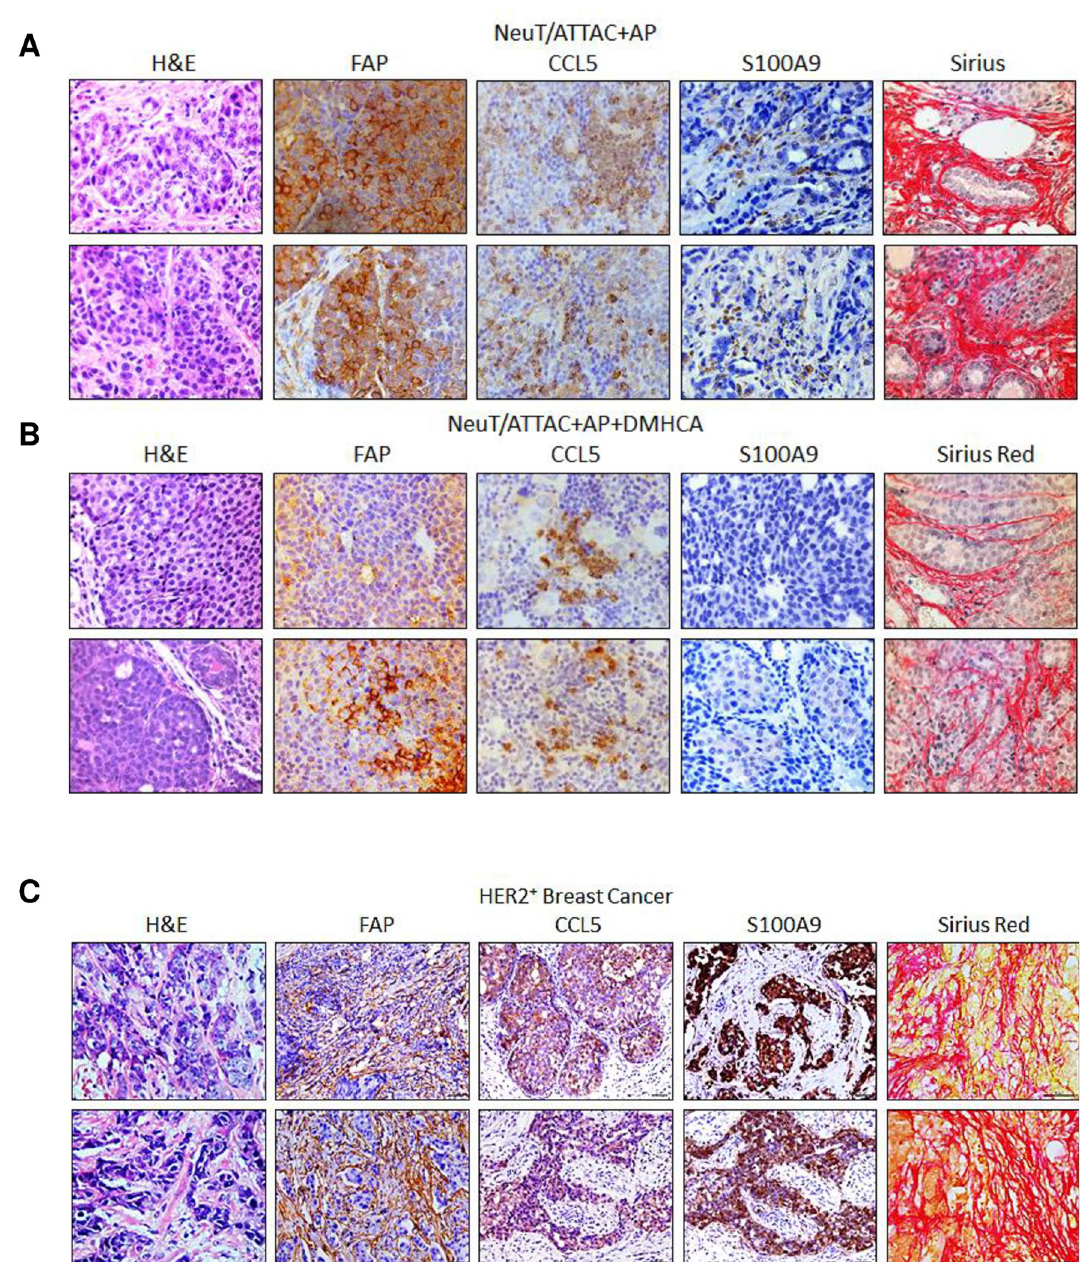
Fig 3. Comparison of FAP, CCL5, S100A9 and collagen expression in HER2+ breast cancer and in tumors from NeuT/ATTC +AP mice and following DMHCA treatment. NeuT/ATTAC mice were administered AP20187 and DMHCA as in Fig 1 and tissues assessed by H&E staining, FAP, CCL5 and S100A9 by IHC and collagen by PicroSirius Red staining.